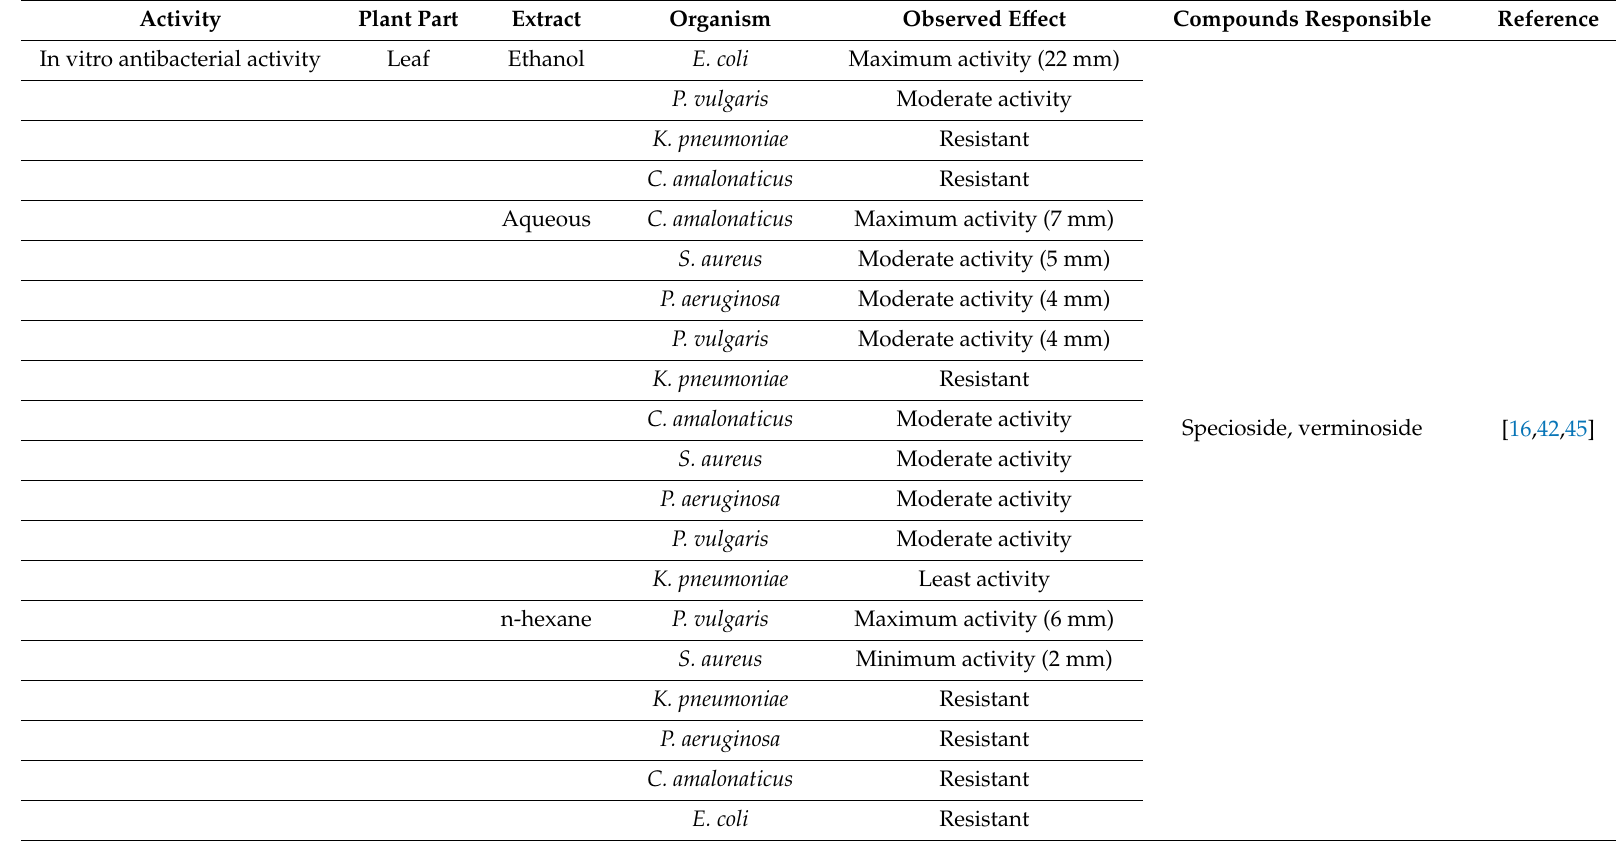
Table 3. Pharmacological activity of Kigelia africana